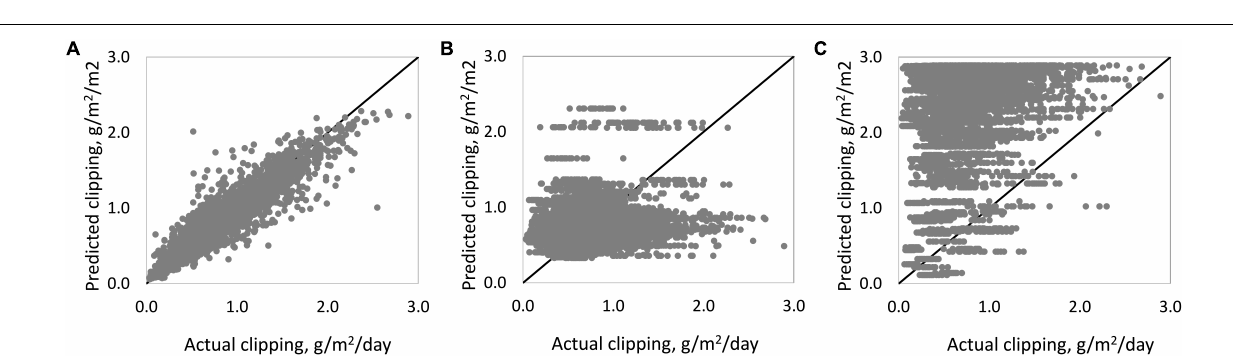
FIGURE 6 | Scatter plot with (A) random forest (RF) model performance from the MN golf course that was built with on-site clipping data; (B) RF model built with clipping data collected from Madison, Wisconsin, USA; (C) PACE Turf GP